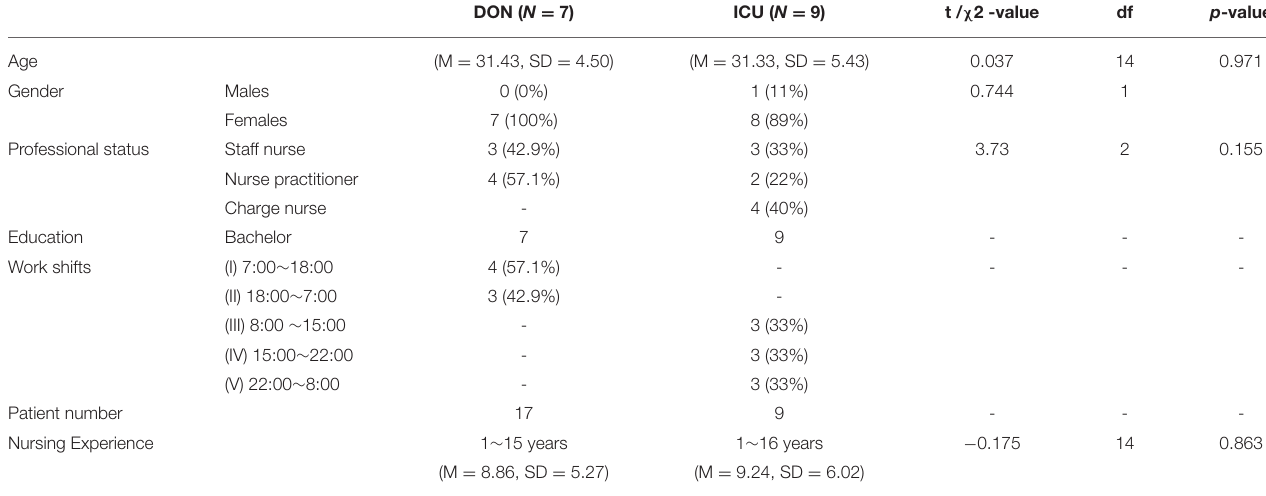
TABLE 1 | Demographic